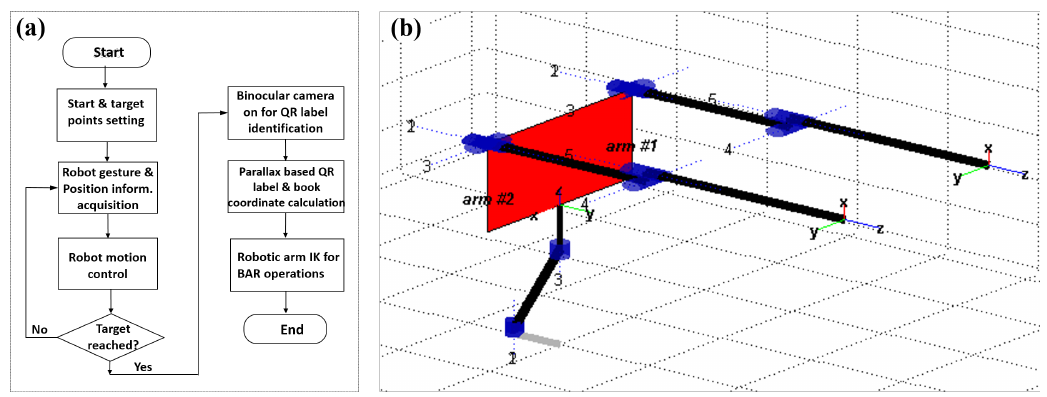
Figure 8. ( a ) The binocular vision based robot BAR operation control mechanism. ( b ) The modified- DH convention based link diagram for the robotic arms.